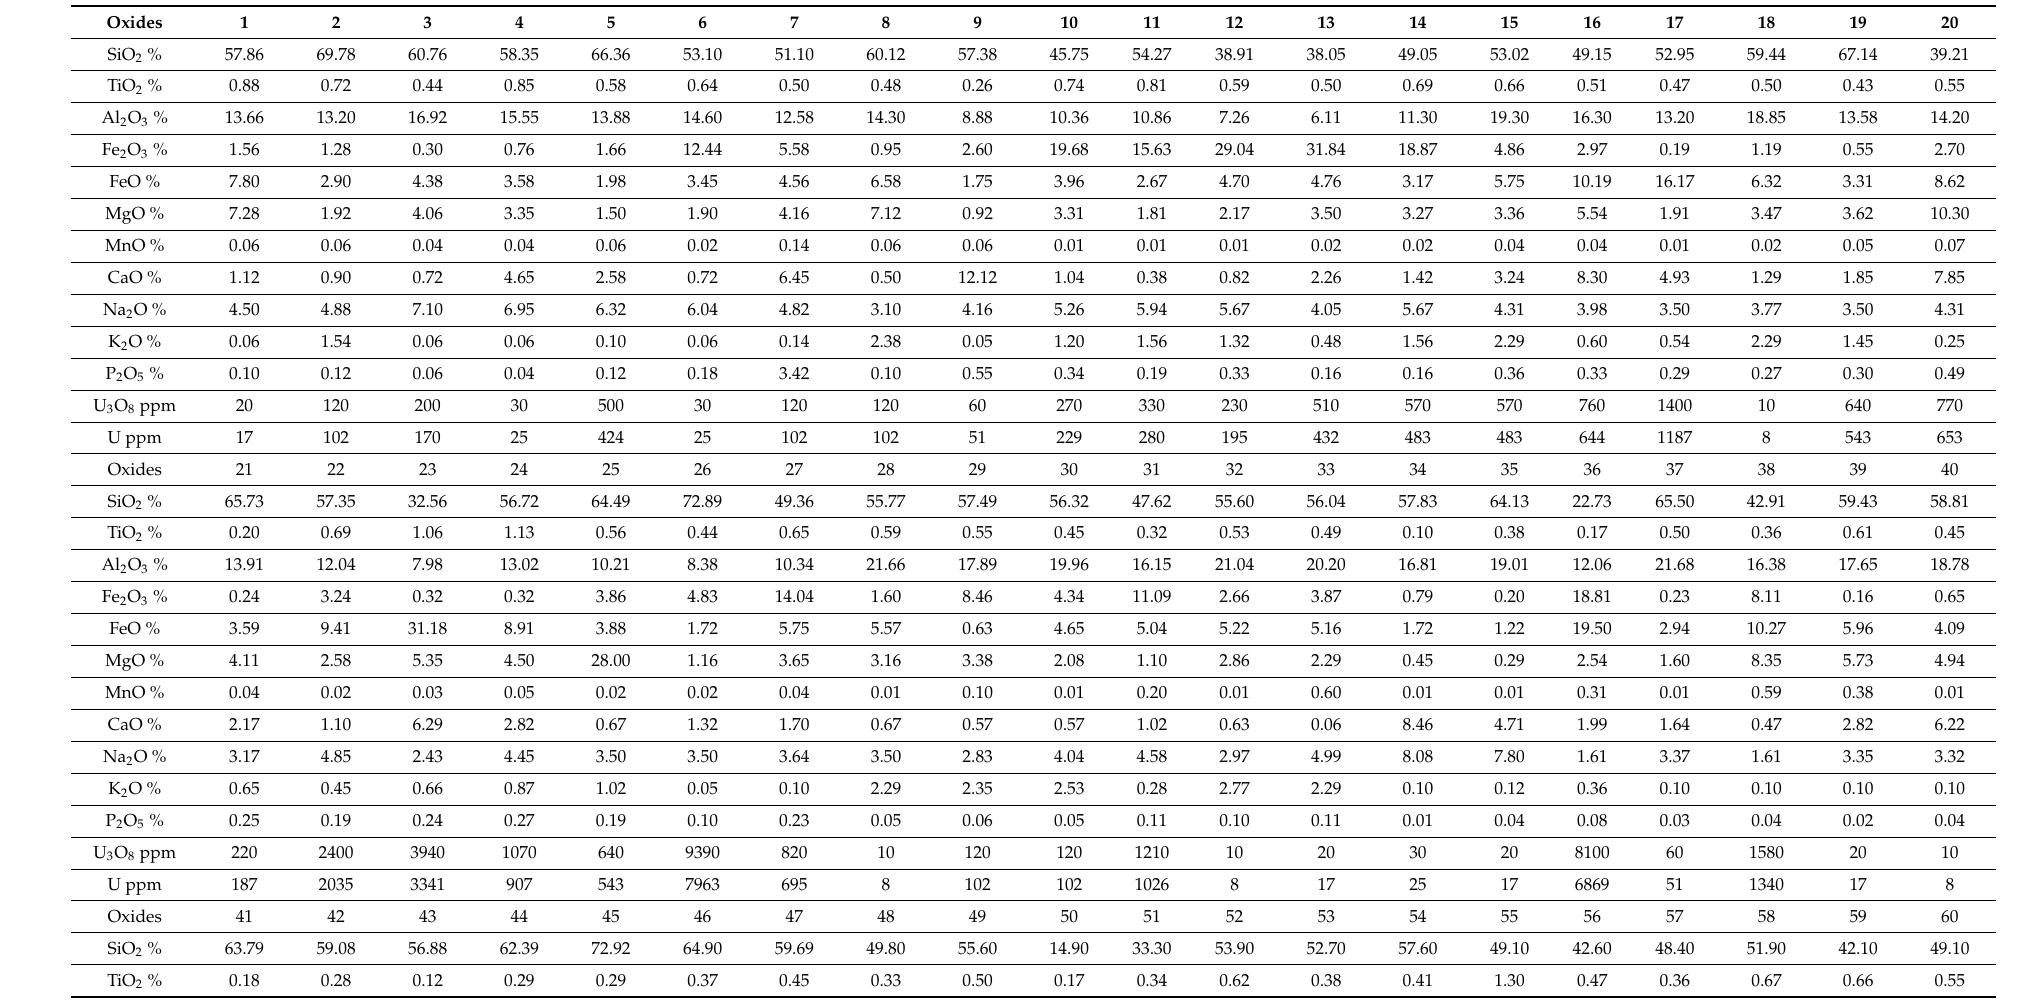
Table 5. Wet geochemical analysis data of major